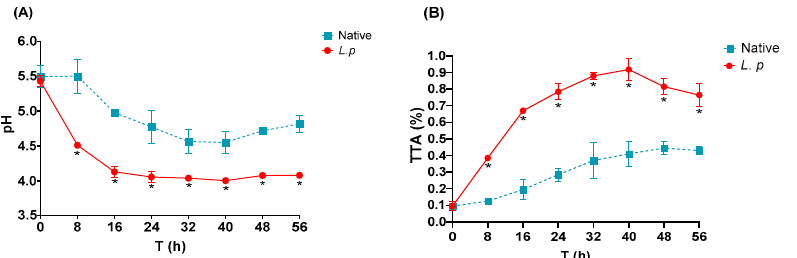
Figure 3. Temporal course of pH ( A ) and % TTA ( B ) of the native and controlled fermentation ( Lp ) of the C. ficifolia juice for 56 h. * Significant difference ( p < 0.05) against native fermentation juice. T-paired test (Mean ± S.D., n = 3), Tukey’s post hoc test.